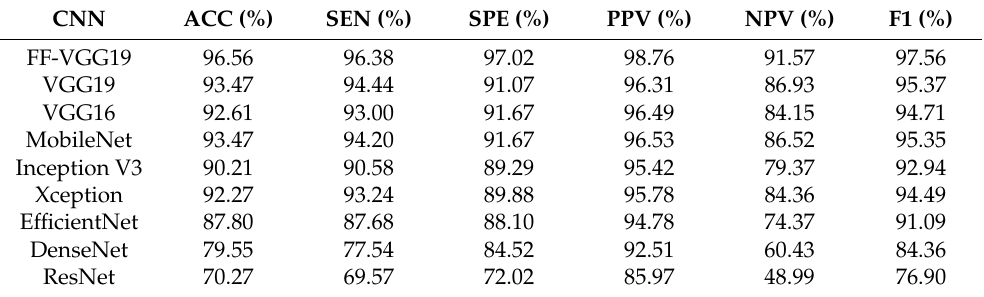
Table 4. Comparison of ParaNet performance when using different CNN components for each path. ACC, Accuracy; SEN, sensitivity; SPE, specificity; PPV, positive predictive value; NPV, negative predictive value; F1, F1 score.